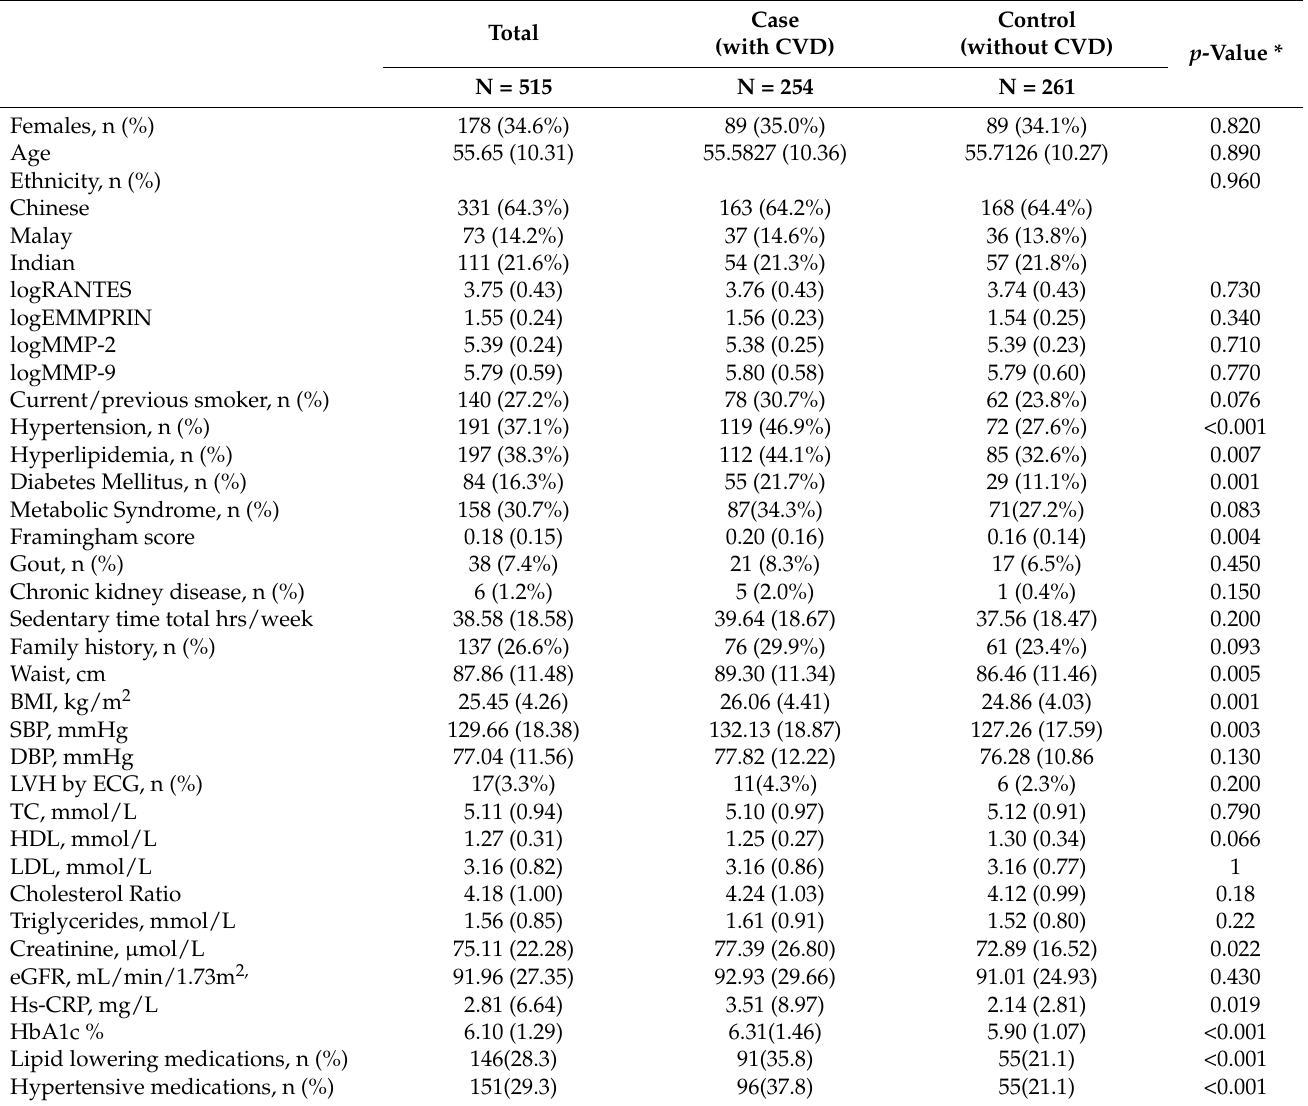
Table 1. Characteristics of the study